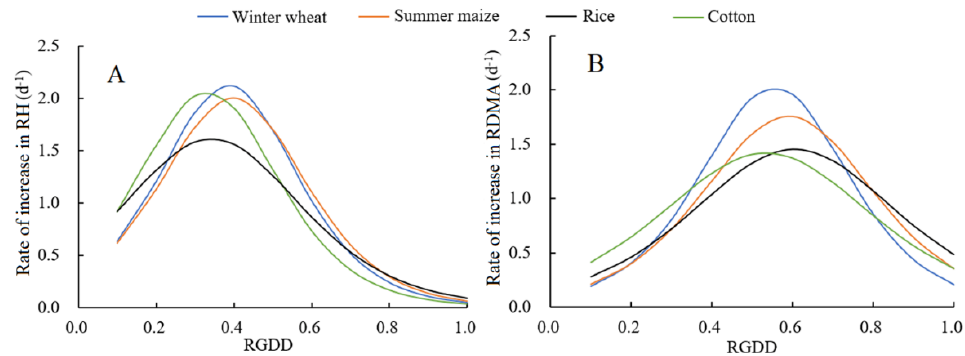
Figure 5. Relationships between relative growing degree days (RGDD) and the rates of increase in ( A ) RH and ( B ) RDMA for each crop. ( A ) RH and ( B ) RDMA for each crop.